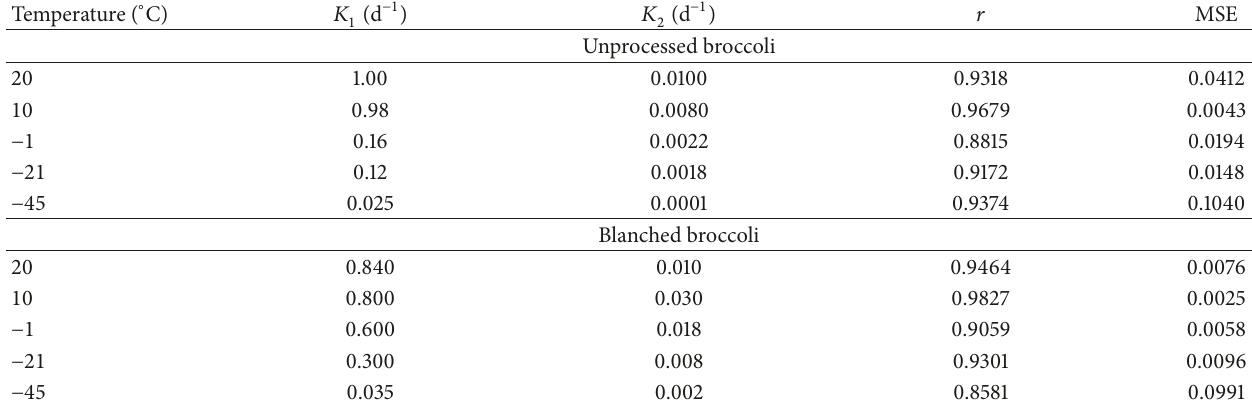
Table 1: Kinetic parameters estimates ( 𝑟 and MSE) for evolution of TPP content in unprocessed and blanched broccoli stored at different temperatures. “ 𝑟 ” is the Pearson’s correlation coefficient and MSE is the mean squared error. 𝐶 pre ,0 was estimated from the experimental data, and it was equal to 320 mg GAE/g DM for unprocessed broccoli and 220 mgGAE/g DM for blanched broccoli.